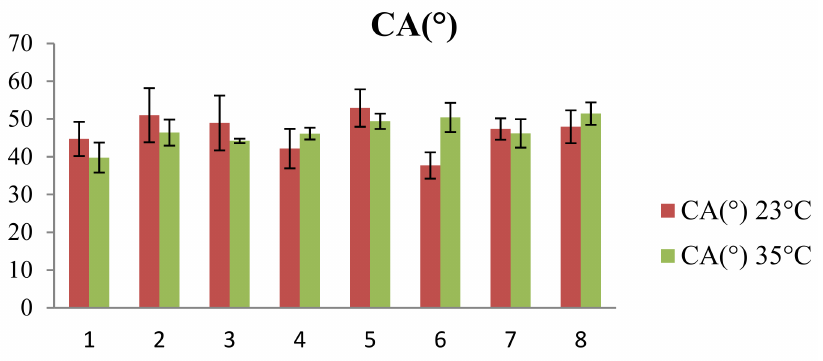
Figure 2. Comparative graphical representation of the contact angle values for the 8 samples analyzed at the two temperatures (23 ◦ C and 35 ◦